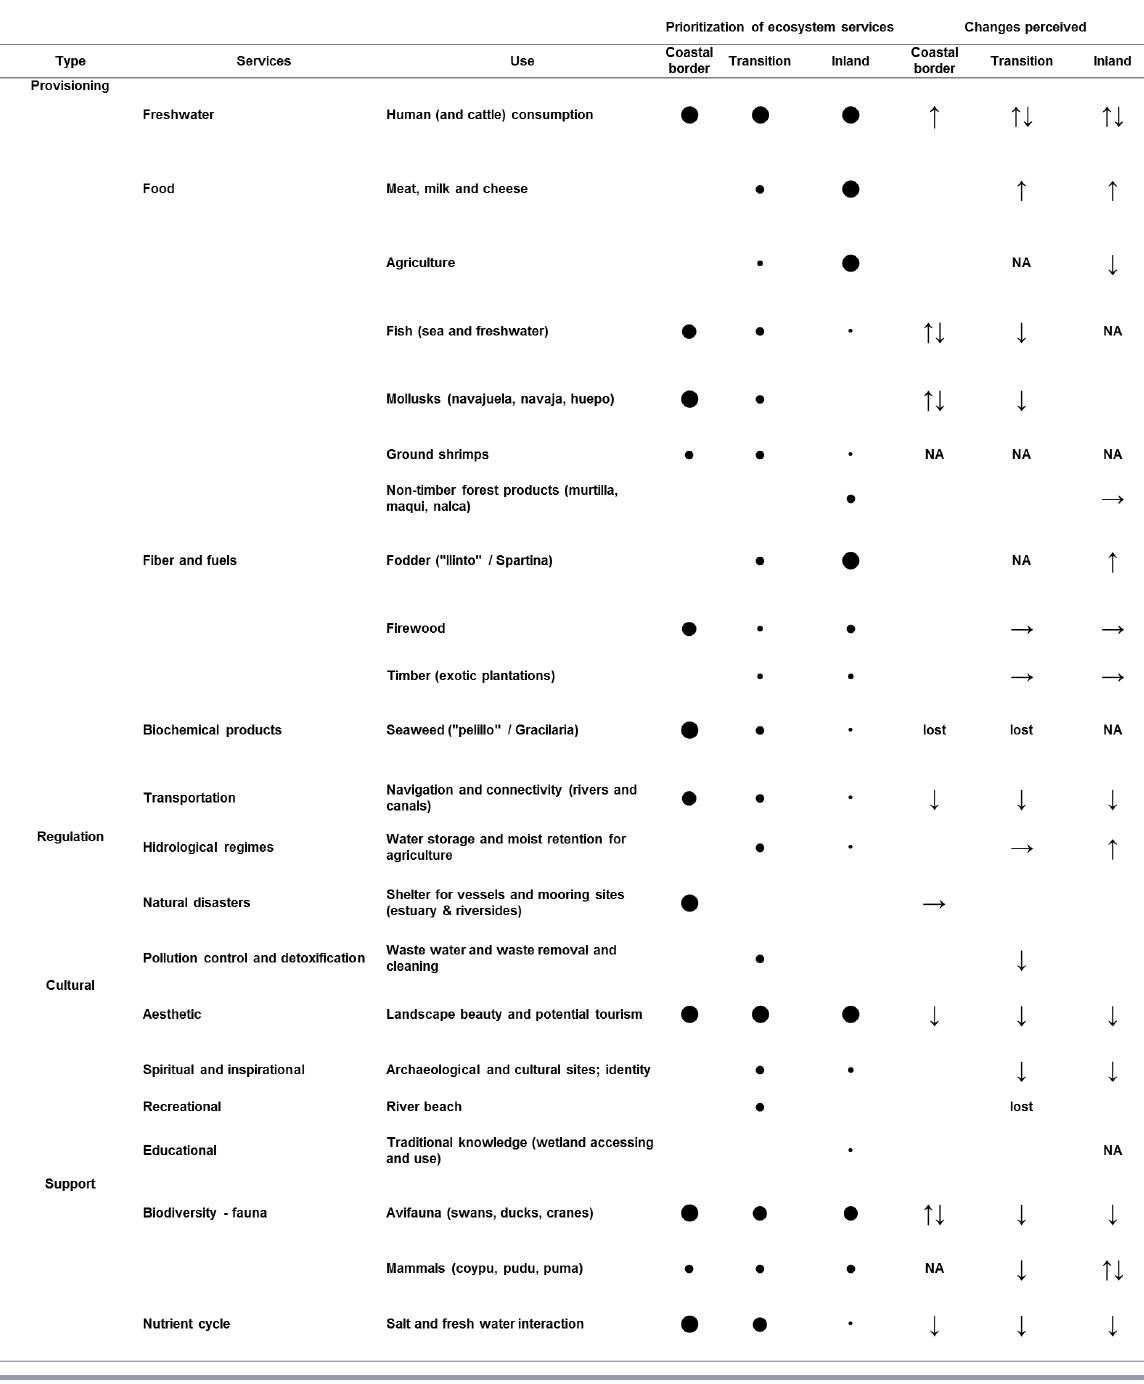
Fig. 3 . Users’ prioritization of wetland ecosystem services for human well-being and perceived changes in Tubul-Raqui after the 2010 earthquake. Legend: the size of circles represents the level of importance of each ecosystem service for human well-being as assessed by users (larger circles express higher importance); arrows represent the changes observed by users in ecosystem services after the earthquake, namely ↑ = increase; ↓ = decrease; → = maintenance; ↑↓ = increase and decrease in different places; NA = not